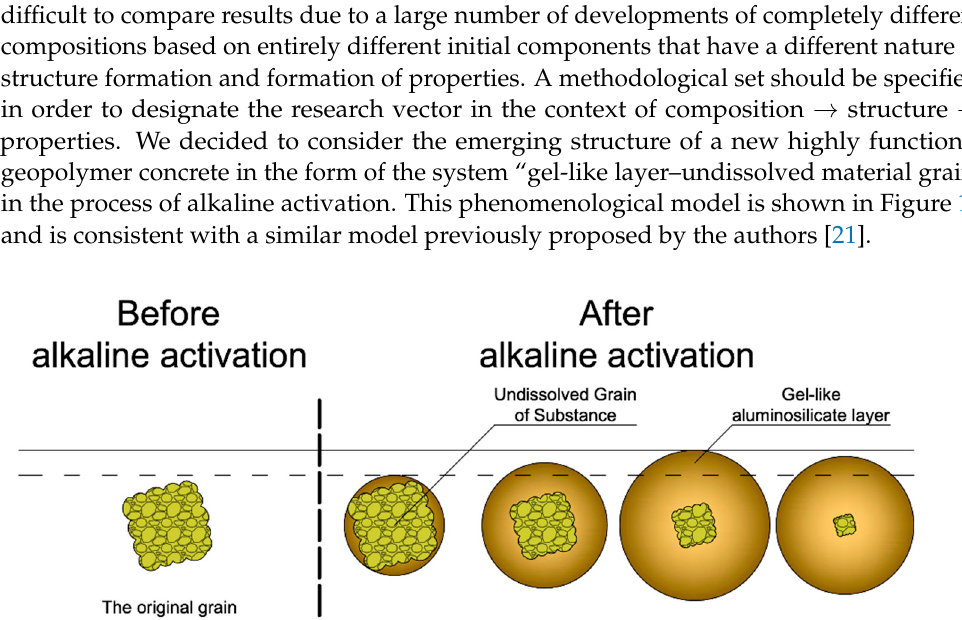
Figure 12. Microstructure of the geopolymer composite at the age of 28 days: ( a ) composition of type C; ( b ) composition of type 8B.